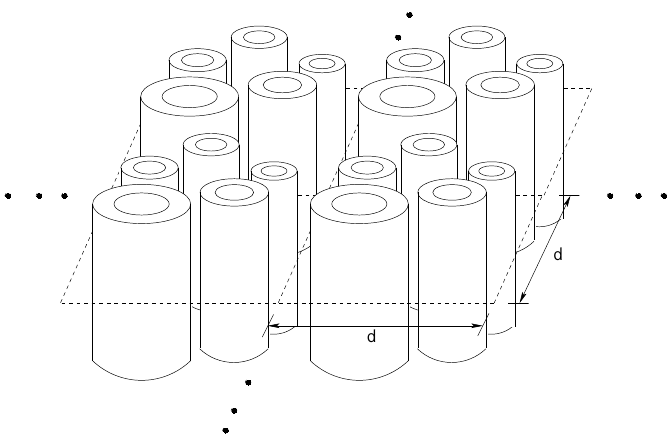
Figure 1. Photonic crystal made from coated